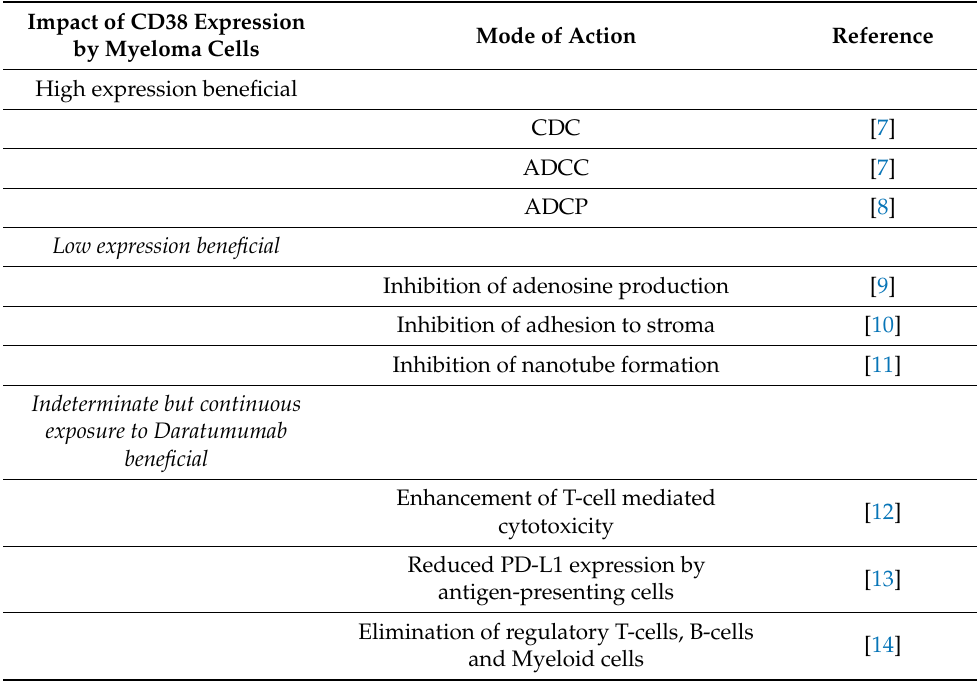
Figure 2. Overall survival of myeloma patients treated with Daratumumab monotherapy [6]. ( A ) All patients. ( B ) Patients stratified by response as Responders (Partial Response or better); Minor Response or Stable Disease (MR/SD) or Progressive Disease/Not Evaluable (PD/NE). Abbreviations: OS = Overall Survival; NE = Not Evaluable. Table 2. Immune mediated killing of myeloma cells, reprogramming of the host’s immune system and modulation of the bone marrow microenvironment by Daratumumab.